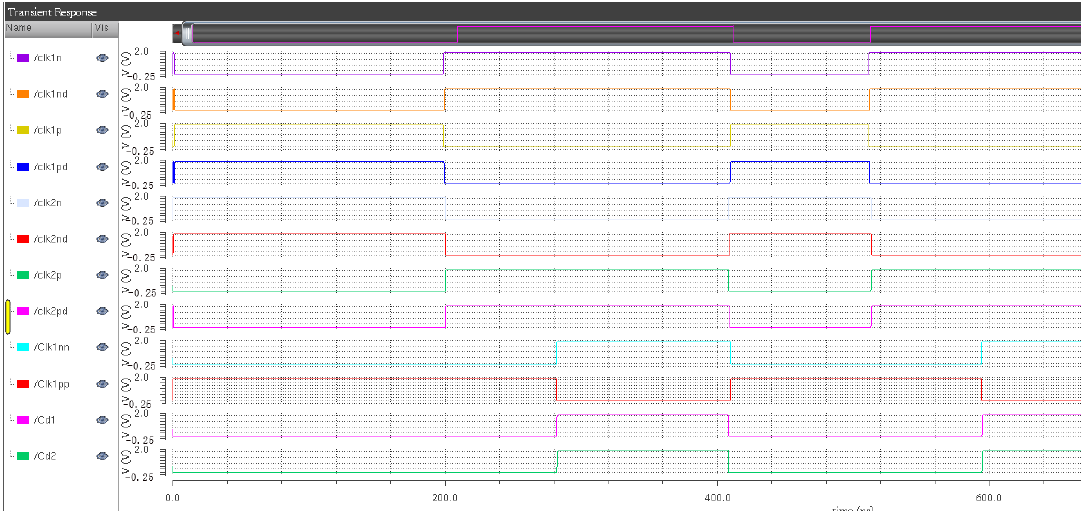
Figure 10. Overall clock simulation diagram of the integral part.